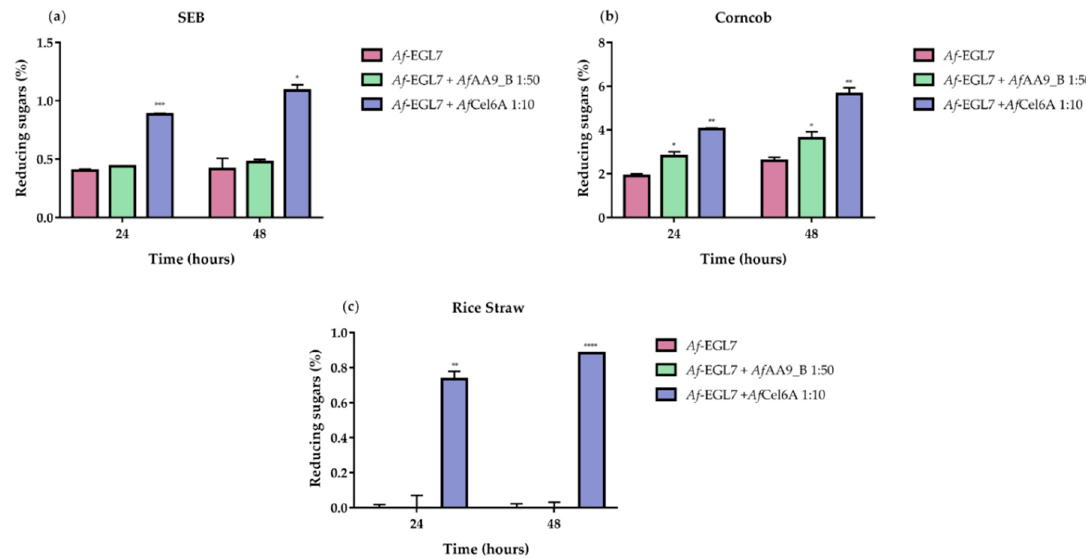
Figure 9. Combined activities of Af -EGL7 and Af Cel6A or Af AA9_B on the hydrolysis of ( a ) SEB; ( b ) corncob; and ( c ) rice straw. All reactions were incubated in 50 mM sodium phosphate buffer (pH 6.0) containing 1% ( w/v ) of each biomass for 24 and 48 h at 50 ◦ C and 1000 rpm. At the end of each reaction, the measured reducing sugars were plotted in function of the relative proportions between the recombinant enzymes. Asterisks indicate significant difference ( p < 0.05) in relation to the Af -EGL7